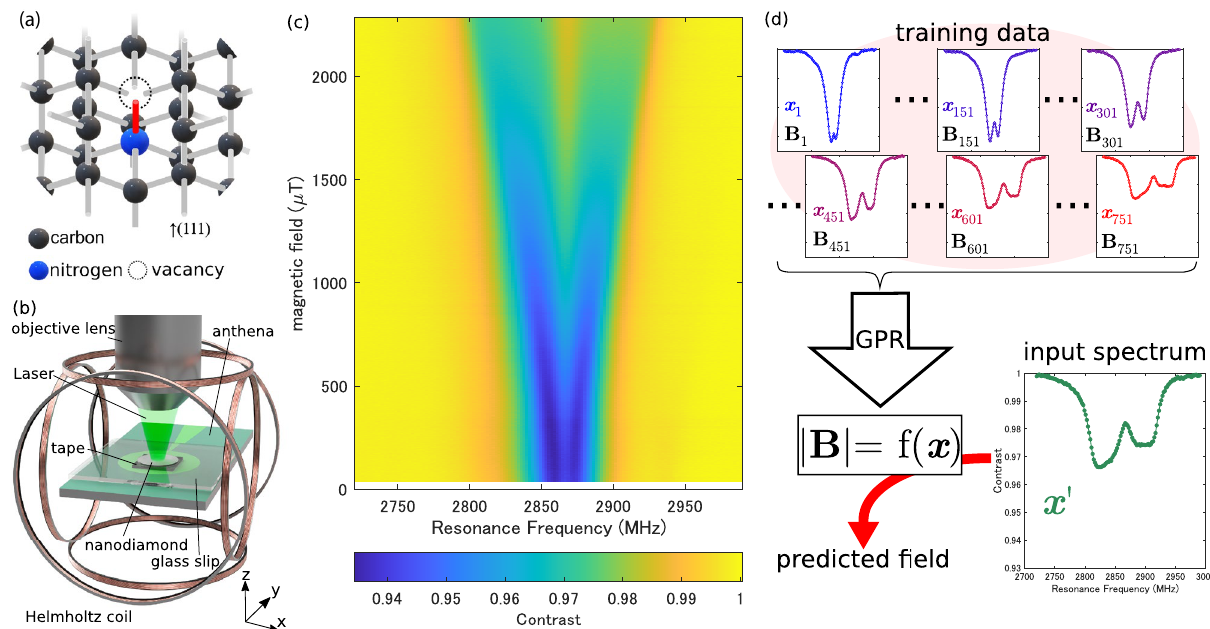
Figure 1. Implementation of nanodiamond quantum sensors enhanced by machine learning. ( a ) Schematic of a nitrogen-vacancy (NV) center in diamond. ( b ) Experimental setup. The optical axis is the z-axis, and the NDE is spread on the surface in the xy-plane. ( c ) Experimentally obtained ODMR spectra of NDE as functions of the microwave frequency and the magnetic field. The true magnetic field is measured using a tesla meter. ( d ) Schematic of our machine learning method. The ODMR spectrum and the true magnetic field of ( c ) are used as the input vector x i and output scalar y i for training, respectively. Using GPR, a function is obtained from the B f ( x ′ ) from an unknown spectrum x ′ training data to predict the magnetic field strength | | =